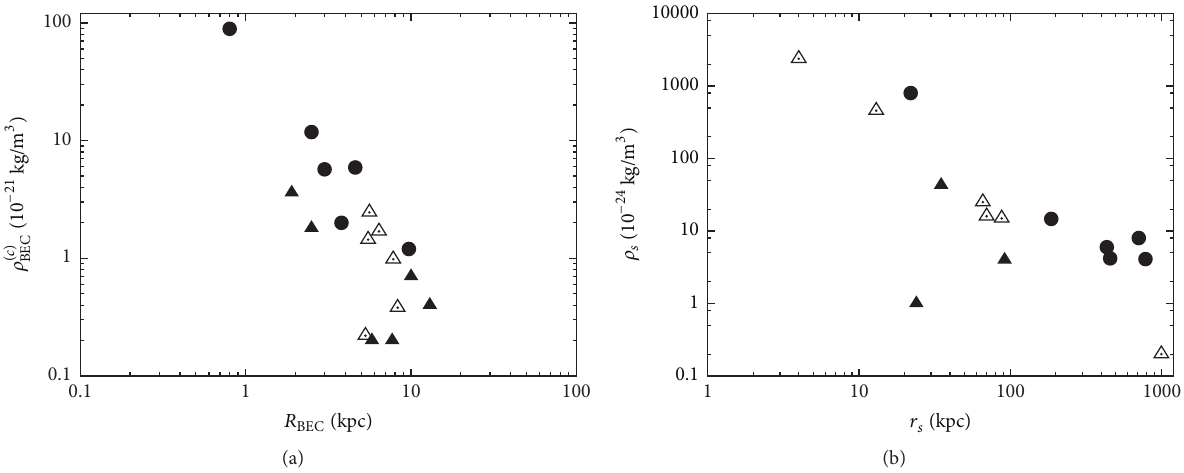
Figure 6: The density parameter 𝜌 (𝑐) of the BEC model is shown as function of 𝑅 BEC is shown as function of 𝑟 𝑠 in (b). The HSB, LSB, and dwarf galaxies are represented by filled circles, empty triangles, and filled triangles, respectively.